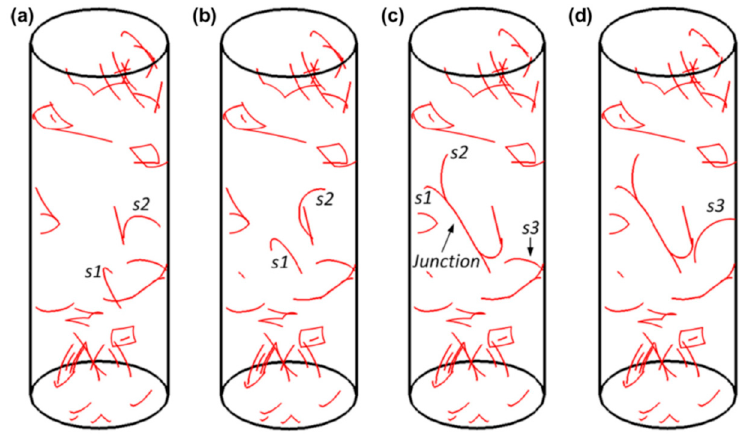
Figure 9. Evolution of engineering stress and dislocation density versus total strain in a Ni pillar with the diameter of 1 μ m during compression simulated using 3D discrete dislocation dynamics (after Zhou et al. [55]).